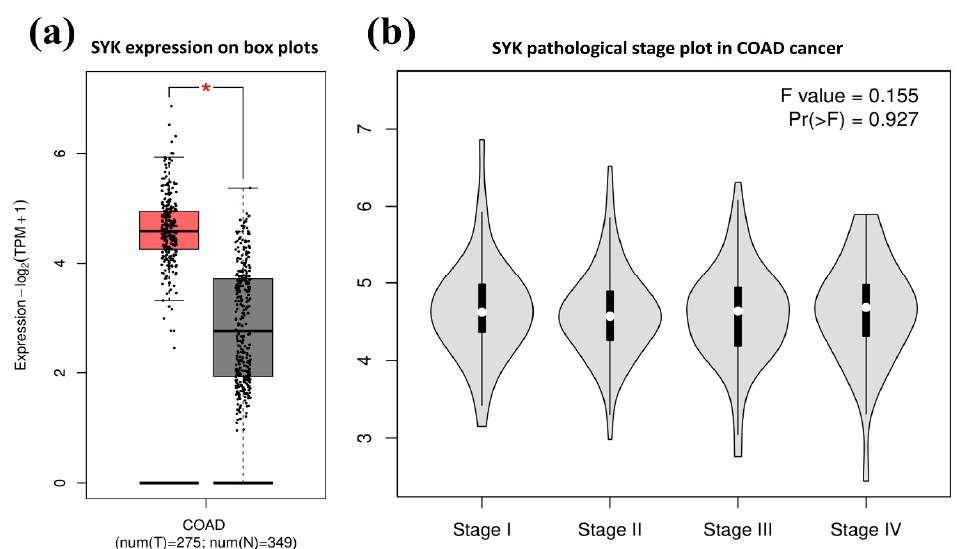
Figure 2. Expression profile analysis of SYK gene in TCGA COAD between normal and different cancer stages based on other variables using the UALCAN database. ( a ) SYK expression in COAD is based on sample types. ( b ) SYK expression in COAD is based on individual cancer stages. ( c ) SYK expression in COAD is based on the patient’s race. ( d ) SYK expression in COAD dependent on the patient’s gender. ( e ) SYK expression in COAD is based on the patient’s weight. ( f ) SYK expression in COAD is based on the patient’s age. ( g ) SYK expression in COAD is based on the histological subtype. ( h ) SYK expression in COAD is based on the nodal metastasis status. ( i ) SYK expression in COAD is based on the TP53 mutation status. Statistically significant p -values are marked in bold.